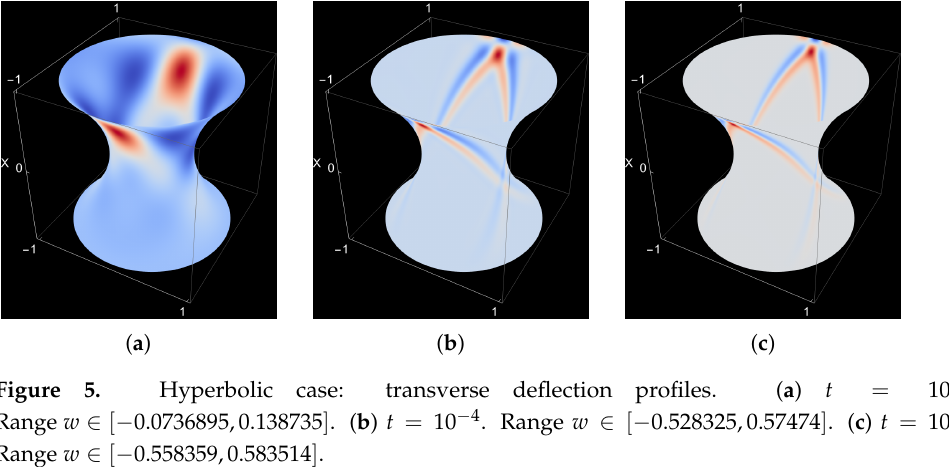
Figure 5. Hyperbolic case: transverse deflection profiles. ( a ) t = 10 − 2 . Range w ∈ [ − 0.0736895,0.138735 ] . ( b ) t = 10 − 4 . Range w ∈ [ − 0.528325,0.57474 ] . ( c ) t = 10 − 6 . Range w ∈ [ − 0.558359,0.583514 ]